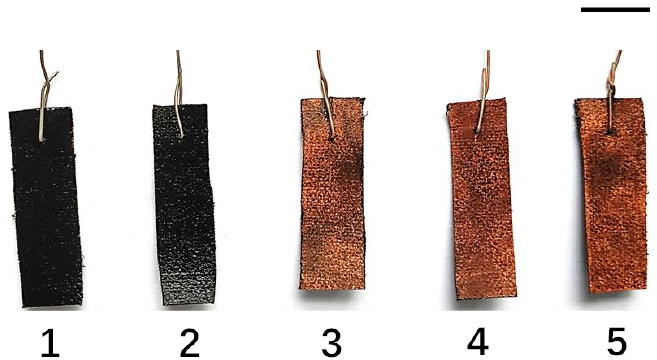
Figure 8. The cathodes of the MFCs after the treatment of simulated AMD. ( 1 : abiotic; 2 : glucose; 3 : acetate; 4 : ethanol; 5 : lactate).